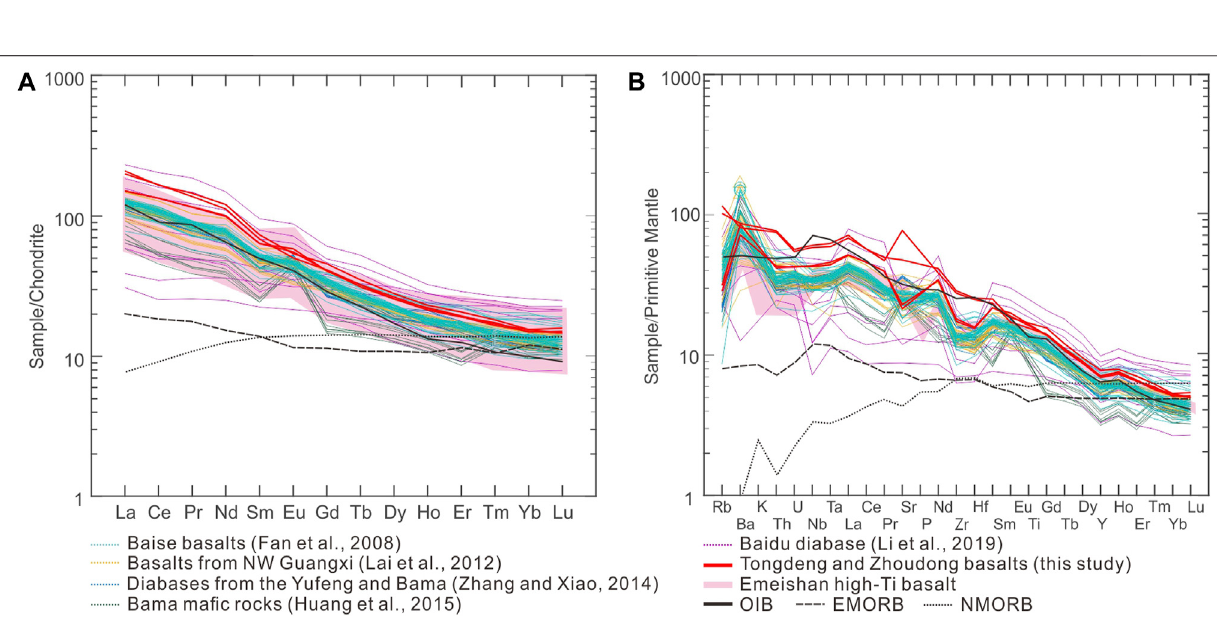
Xiaoren Samples For the 29 Hf analysis spots ( Table 3 ), 13 spots (with weighted average age of 257.9 Ma) yielded 176 Hf/ 177 Hf (cid:1) 0.282245 – 0.282492. Zircons ( n (cid:1) 30) from sample XR-1 show oscillatory zoning in Calculated with their respective zircon U-Pb age, the zircons have CL images ( Figure 7C ). Most of them are 80 – 110 μ m long and ε Hf(t) (cid:1) − 13.22 to − 4.15 (avg. − 10.20) and one-stage model age 50 – 80 μ m with length: width ratio of 1.2 – 1.5. The zircons have (T DM1 ) (cid:1) 1,068 – 1,431 Ma (avg. 1,328 Ma). The remaining 15 analysis high Th/U (cid:1) 0.45 – 1.58 (avg. 0.76). All the data points fall on/near spots yielded 176 Hf/ 177 Hf (cid:1) 0.281438 – 0.282658, and calculated the concordia ( Figure 7D ), yielding a weighted average age of (cid:1) 868 – 2,528 Ma. ε Hf(t) (cid:1) − 14.44 to 11.48 and T 259.6 ± 1.4 Ma (MSWD (cid:1) 0.22) ( Table 2 ). For Hf isotopes DM